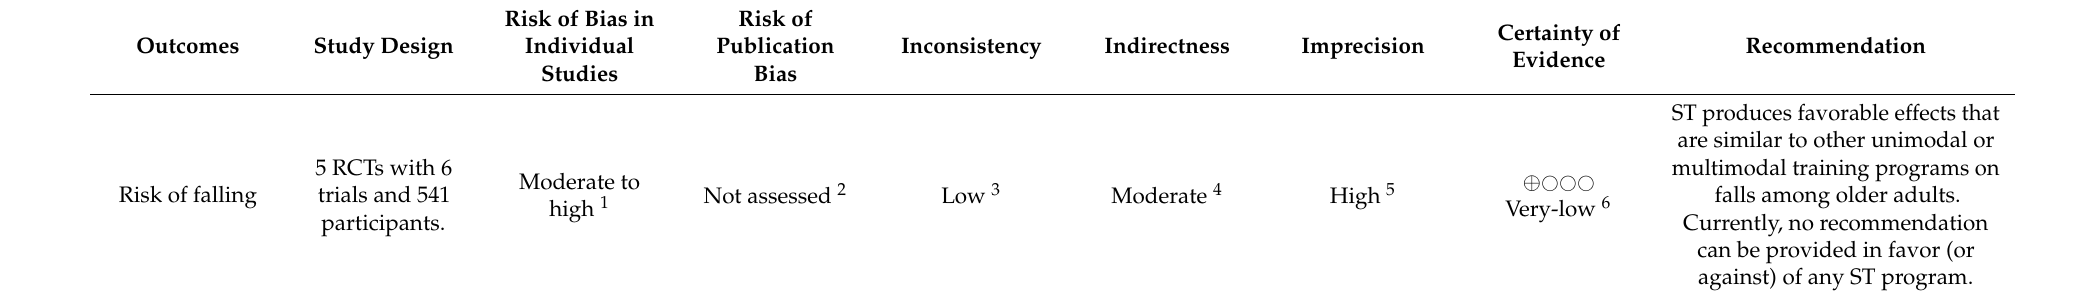
Table 4. GRADE assessment for the certainty of